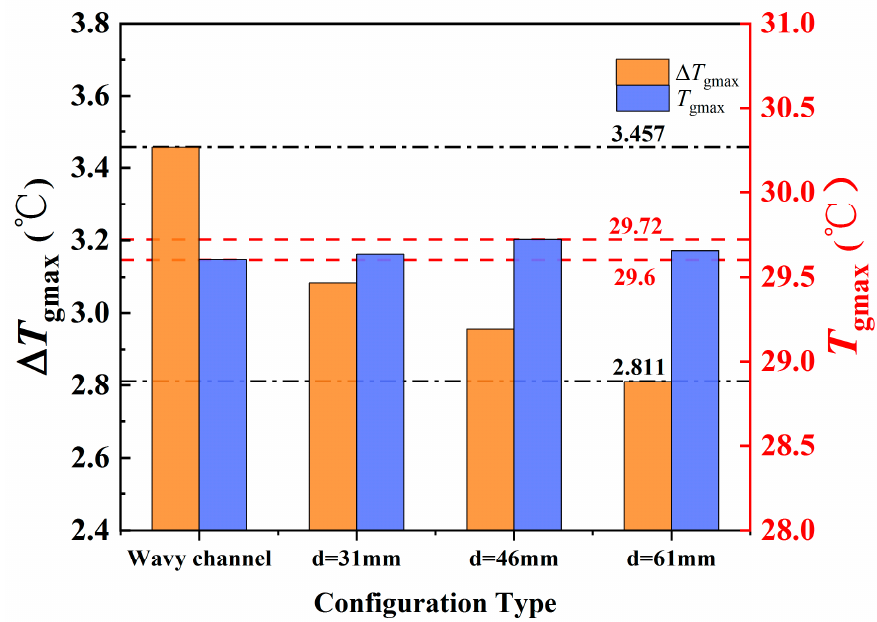
Figure 11. T gmax and △ T gmax of battery module under different configurations.